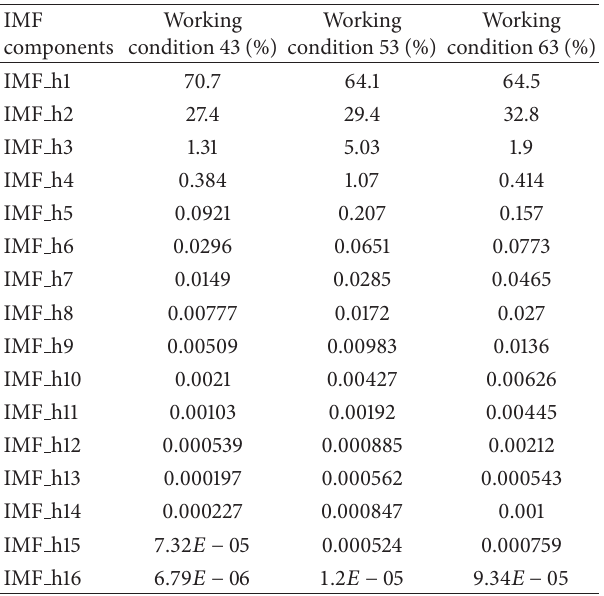
Table 16: IMF component energy percentages of effective micro- seism signals by